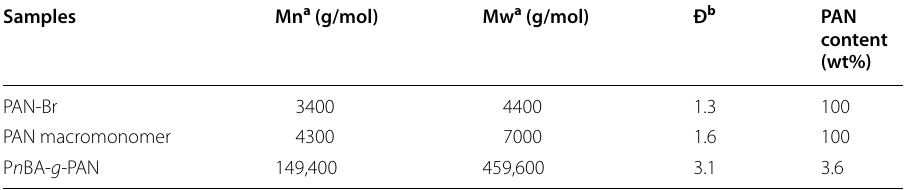
Table 1 Molecular weight characteristic and weight content of PAN-Br, PAN macromonomer and P n BA- g -PAN graft